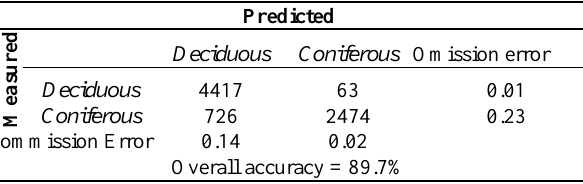
Table 3. Confusion matrix for coniferous-deciduous